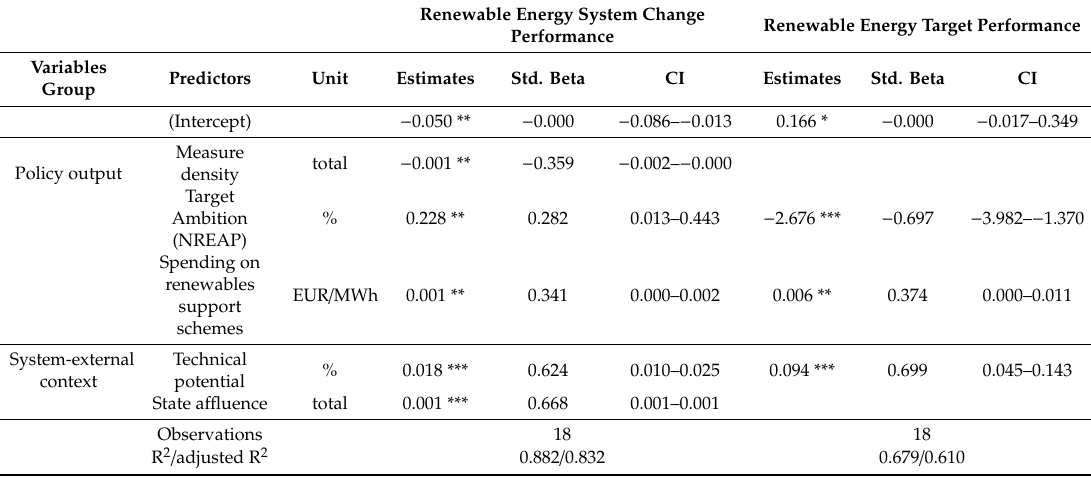
Table 3. Predictors for renewable energy performance (system change and target performance) estimates including 95% confidence